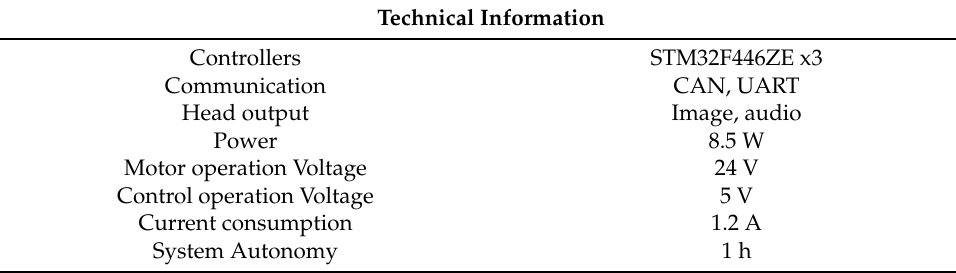
Table 3. Technical information of the prototype of the robot arms and